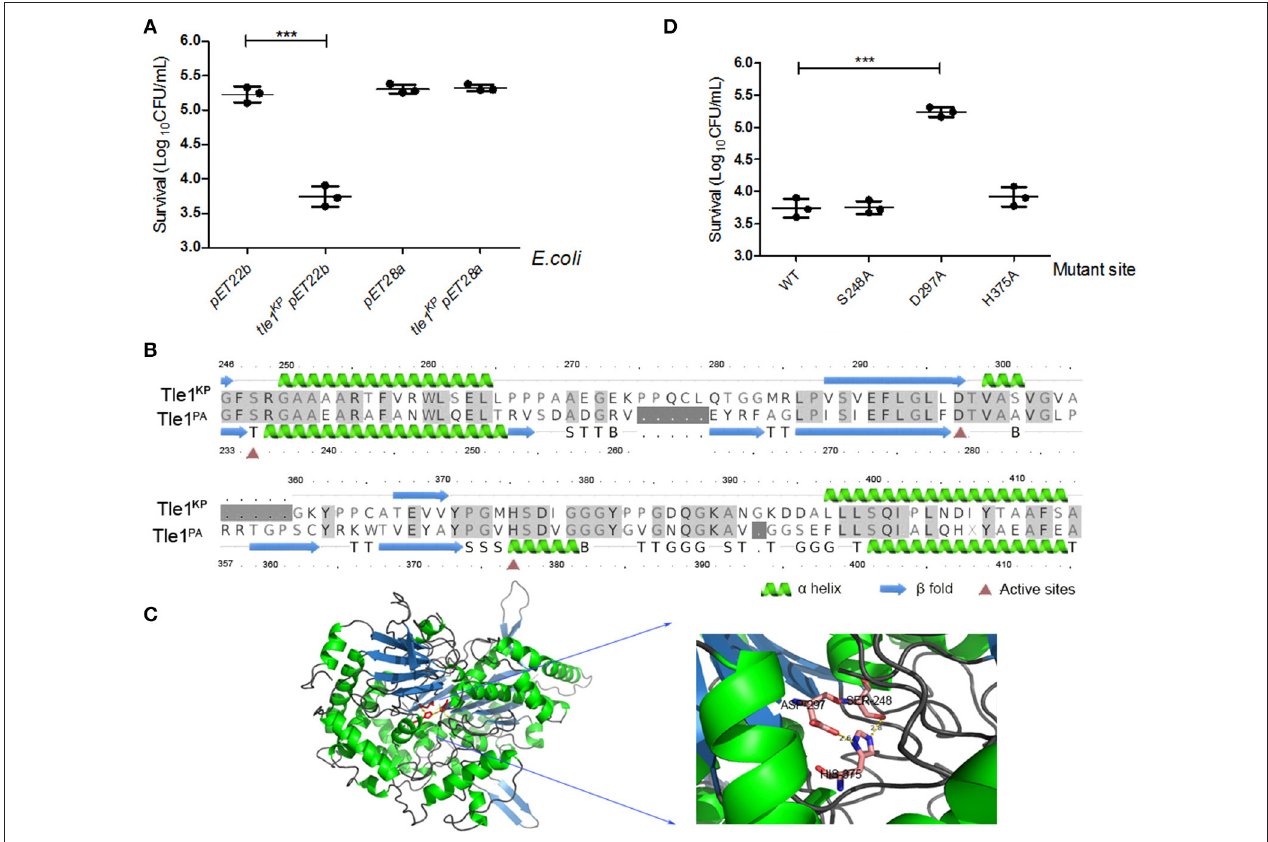
FIGURE 5 | Characterization of the T6SS effector Tle1 KP . (A) The growth of E. coli BL21 containing tle1 KP pET22b and tle1 KP pET28a on LB agar induced by IPTG. BL21 with an empty vector was included as a control. pET22b contains a periplasm-targeting signal. Ten-fold serial dilutions of overnight culture were grown on LA media plates with selective culture medium. (B) Amino acid sequence alignment for Tle1 KP and the Tle1 PA of P. aeruginosa ( Hu et al., 2014). Red triangles highlight the characterized active sites of phospholipase Tle1 PA . (C) The 3D structure and active site of Tle1 KP predicted by Phrye2 based on the reported structure of Tle1 PA (PDB entry 405p). (D) Identification of the active sites of Tle1 KP . According to the active sites shown in (C) , E. coli BL21 harboring pET22b expressing wild type and its point mutants in the periplasm were grown in agar plates. The cells were prepared with serial 10-fold dilutions on LA medium and induced by IPTG. Each group